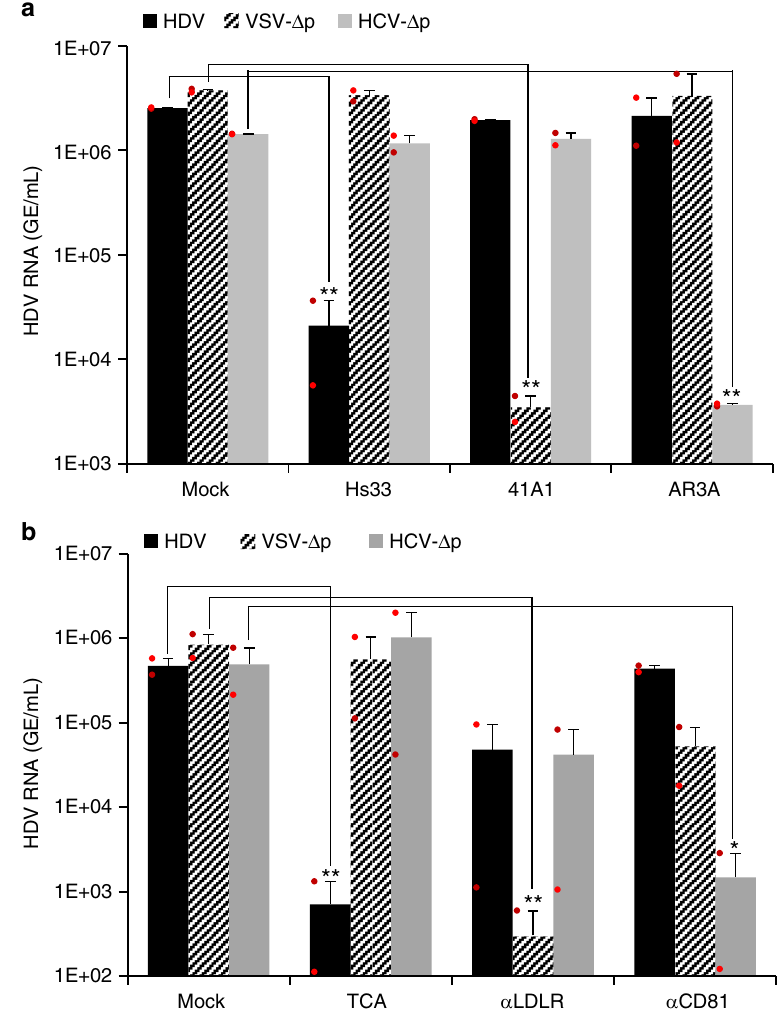
Fig. 4 Speci fi c glycoprotein-receptor interactions mediate cell entry of HDV particles. a Similar inputs of virus particles produced with HBV (HDV), VSV (VSV- Δ p), or HCV (HCV- Δ p) glycoproteins were incubated for 1 h at 37 °C with 100 ng/mL of neutralizing monoclonal antibodies against HBV HBsAg (Hs33 mAb), VSV-G (41A1 mAb,) and HCV-E1E2 (AR3A mAb) glycoproteins vs. no antibody (mock) before infection of Huh-106 cells. b Similar inputs of virus particles were used to infect Huh-106 cells that were pre-incubated for 1 h with compounds that block NTCP (TCA, taurocholic acid), LDLr (C7 mAb), and CD81 (JS-81 mAb) vs. no antibody (mock). Infected cells were grown for 7 days before total intracellular RNA was puri fi ed. The results of HDV RNA quanti fi cation by RT-qPCR are expressed as means ( n = 2 independent experiments) per mL of cell lysates containing 10 6 cells. Source data are provided as a Source Data fi le. Error bars correspond to standard deviation. Statistical analyses (Student ’ s t- test): p < 0.05 (*); p < 0.01